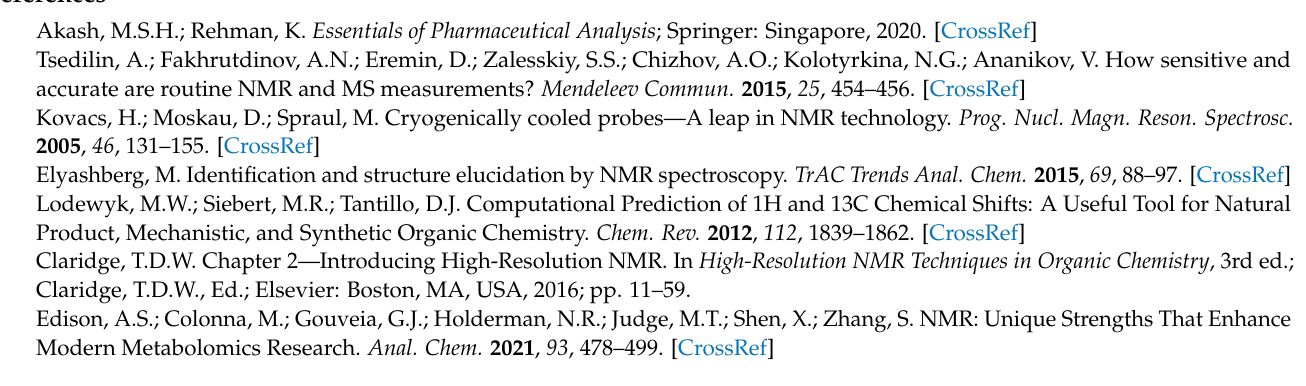
Table S1: Table of information of 24 flavor standards. Table S2: Table of information of the flavor mixtures. Table S3: Table of information of the additional flavor mixture. Table S4: Table of the detailed results of all mixtures in the flavor mixtures dataset. Table S5: Table of detailed results of the mixture in the additional flavor mixture dataset. Table S6: Table of information of the augmented mixtures. Table S7: Table of probabilities of spectral pairs with different chemical shift